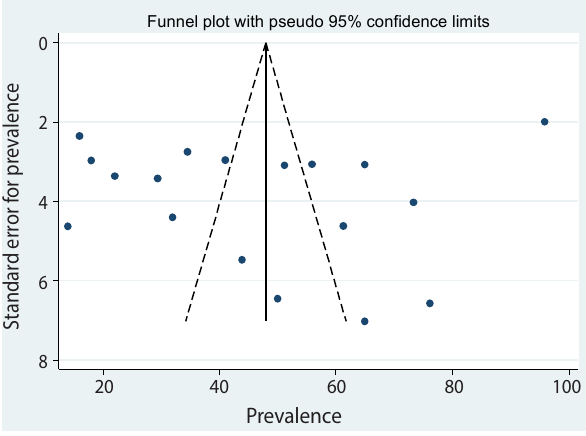
Figure 4. Prevalence of depression among Iranian breast cancer patients based on the year of publication. ES, effect size (prevalence); CI, confidence Figure 5. Funnel plot of the studies included in the meta-analysis. Funnel plot with pseudo 95% confidence limits